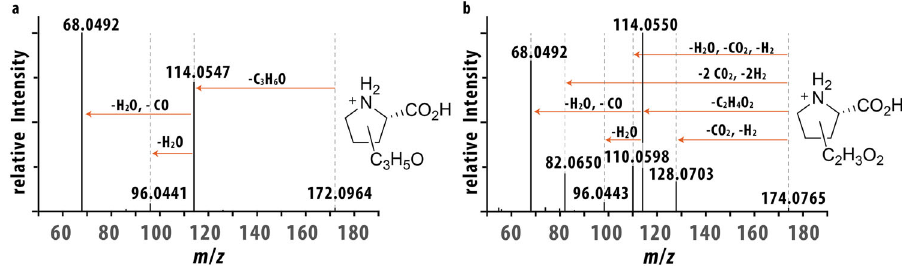
Fig. 2 Collision-induced dissociation (CID) MS/MS spectra of features A and C isolated from HPII plasma samples. a CID MS/MS spectra of feature A ( m/z 172.0964). b CID MS/MS spectra of feature C ( m/z 174.0765).